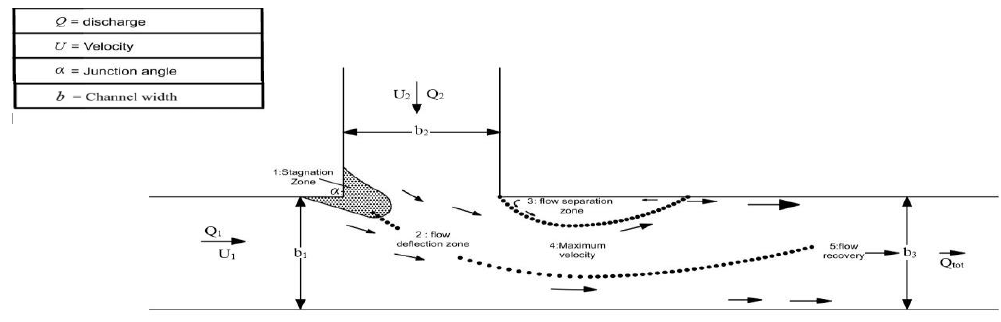
Figure 1. The geometrical structure of confluence based on [2] and modified by [3].